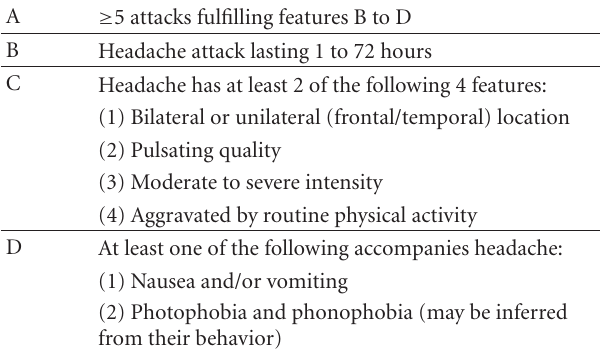
Table 2: Diagnostic criteria for Pediatric migraine without aura.